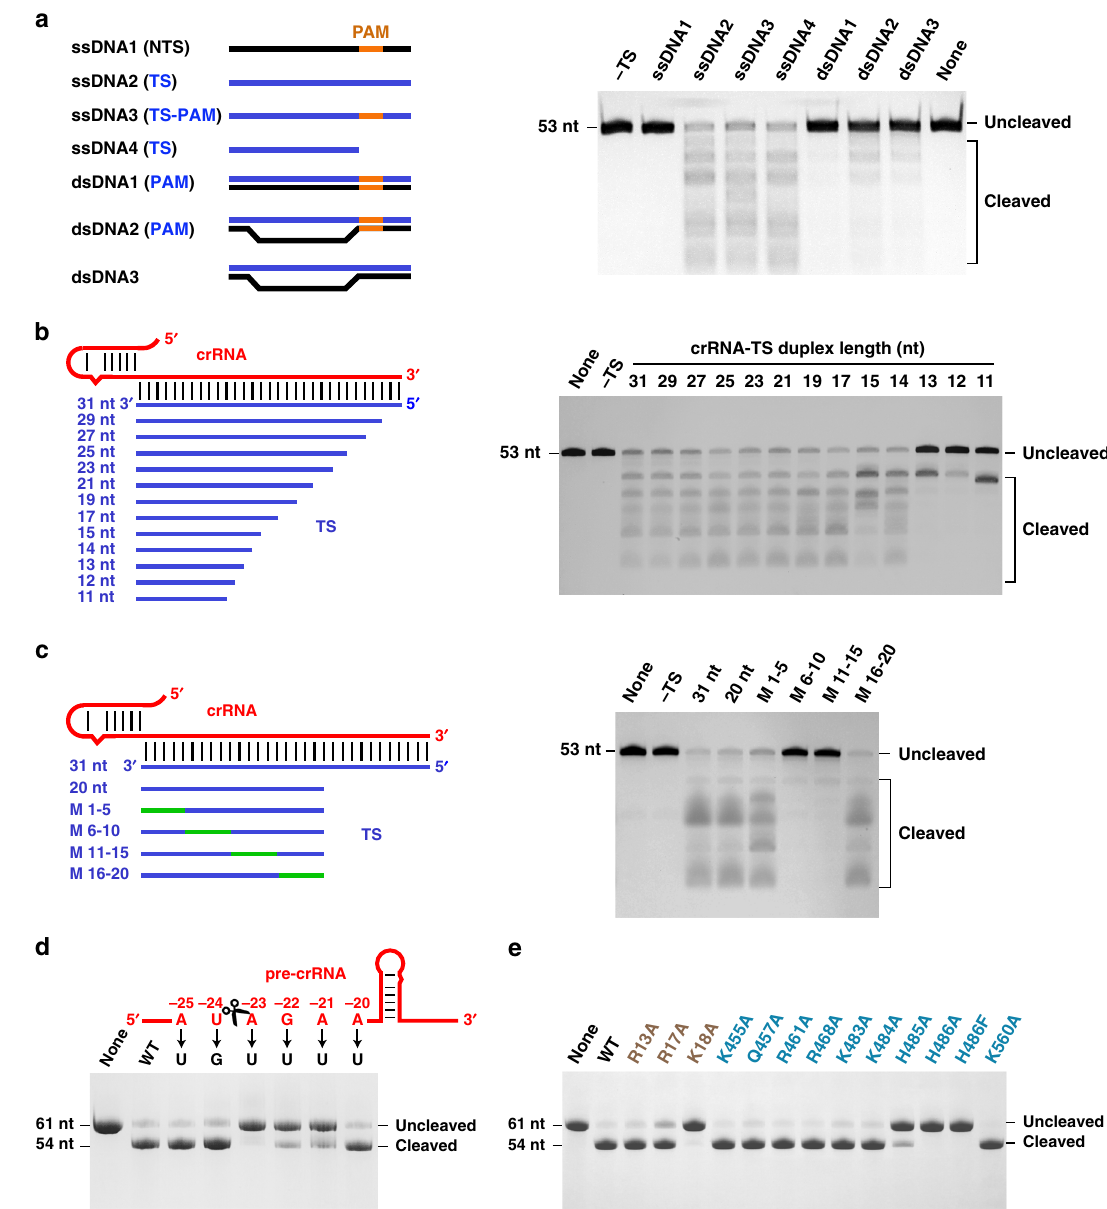
Fig. 6 Cas12i2 target recognition activates non-speci fi c ssDNA cleavage and pre-crRNA processing by Cas12i2. a The formation of the guide:target heteroduplex activates the RuvC catalytic pocket, inducing the trans cleavage of ssDNA in a PAM-independent manner. (Left) Schematic representation of ssDNA and dsDNA activators. The complementary target DNA and non-complementary DNA are in blue and black, respectively. The PAM sequence is highlighted in orange. (Right) The DNA cleavage assay using the 200 nM 5 ′ -Cy3-labeled ssDNA substrate in the presence of 200 nM DNA activators at 37 °C for 15 min. b The length of the complementary ssDNA activator affects non-speci fi c DNA cleavage. (Left) Schematic representation of crRNA and ssDNA activators that is complementary to the guide RNA. (Right) The ssDNA cleavage assay in the presence of ssDNA activators with various lengths. c Mismatches between the target strand DNA and the crRNA spacer region affect activation of the RuvC catalytic pocket. (Left) Schematic representation of crRNA and ssDNA with mismatched regions are highlighted in green. (Right) The ssDNA cleavage assay in the presence of ssDNA activators containing mismatches. d Denaturing gel analysis showing that pre-crRNA processing by Cas12i2 depends on the crRNA repeat sequence shown in the up panel directly downstream of the cleavage site. The cleavage site is indicated by cartoon scissors. The pre-crRNA cleavage assay using the pre-crRNA mutants substrate in the presence of Cas12i2 at 37 °C for 30 min. e Pre-crRNA processing using Cas12i2